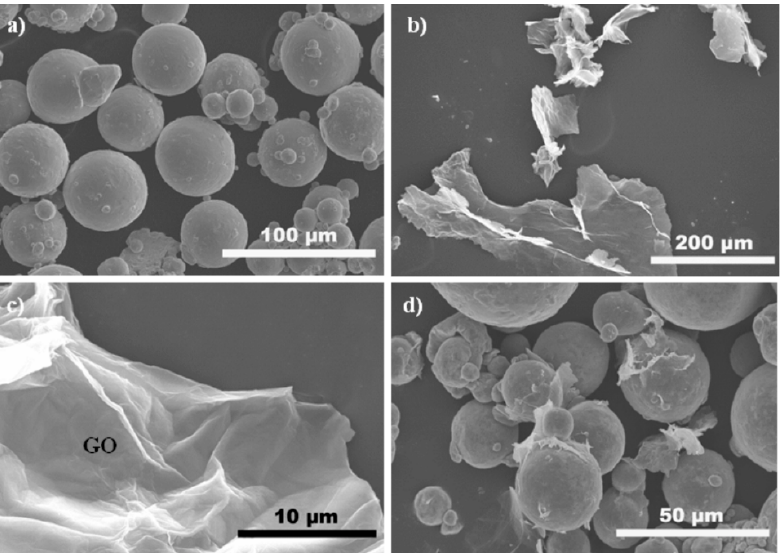
Figure 1. SEM images of the as-received TC4 powders ( a ), GO powders ( b ), GO nanosheet after ultrasonication ( c ), and GO-TC4 composite powders ( d ).